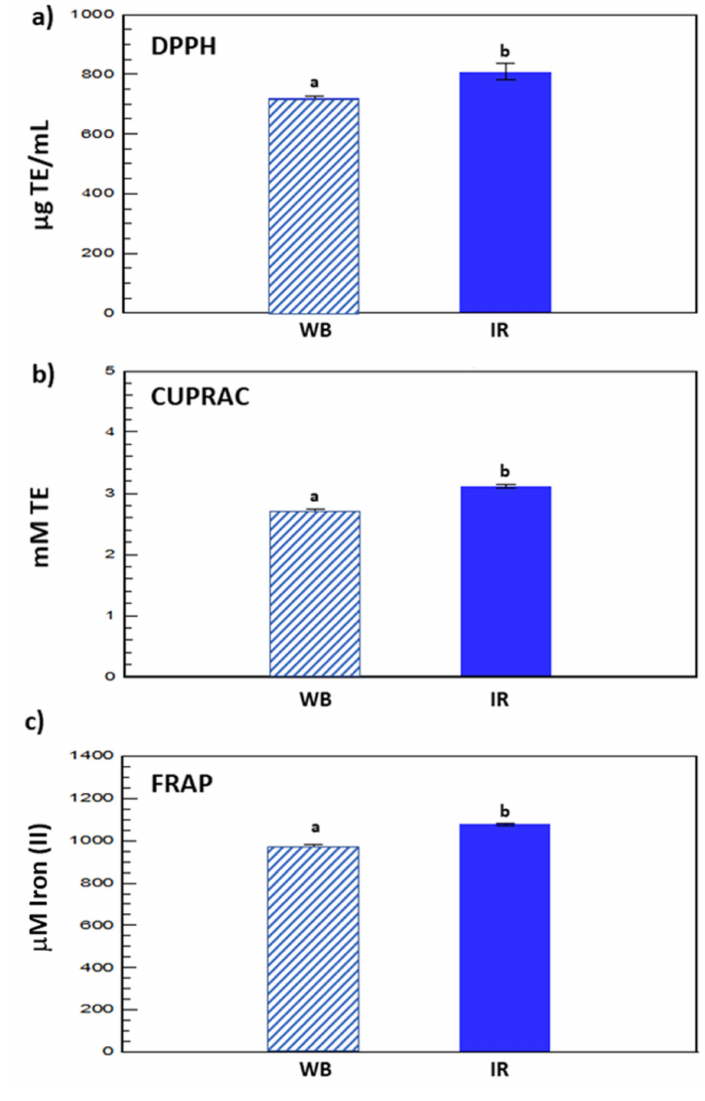
Figure 5. DPPH ( a ), CUPRAC ( b ), and FRAP ( c ) analyses of the WB and the IR extracts. Different letters (a,b) indicate signficant